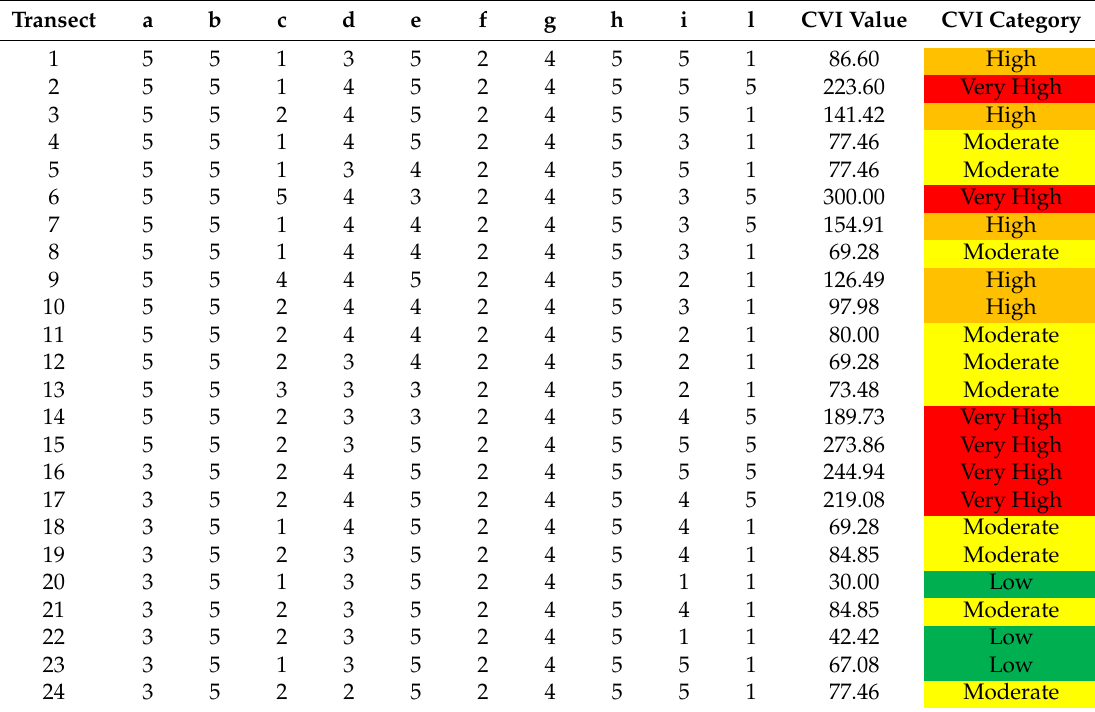
Table 3. Vulnerability value associated to each variable and CVI values for each transect.